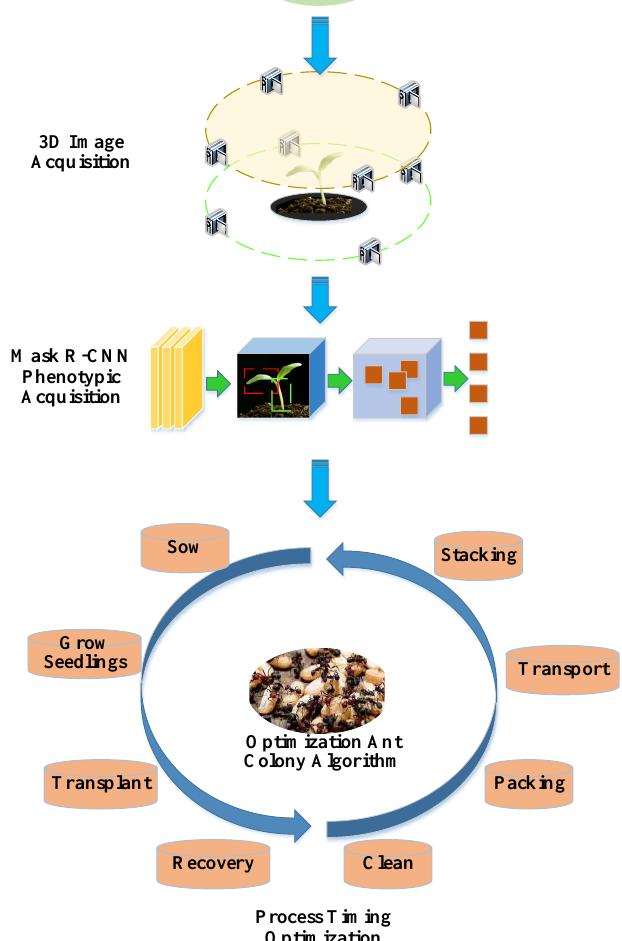
Figure 5. A framework for the fine identification system of plant seedling phenotype under ANN and ACA.